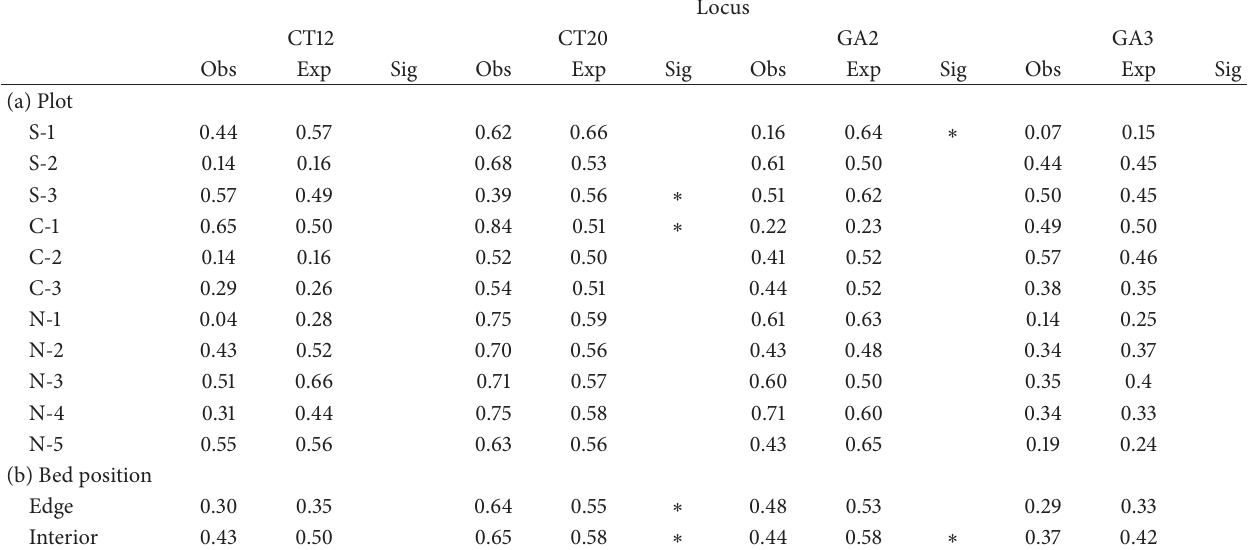
Table 3: Values of observed and expected heterozygosity at four microsatellite loci. Data is arranged by plot and bed position. Multiply sampled multilocus genotypes were excluded. Significant 𝑃 values are denoted by “ ∗ ” which indicates a departure from Hardy-Weinberg